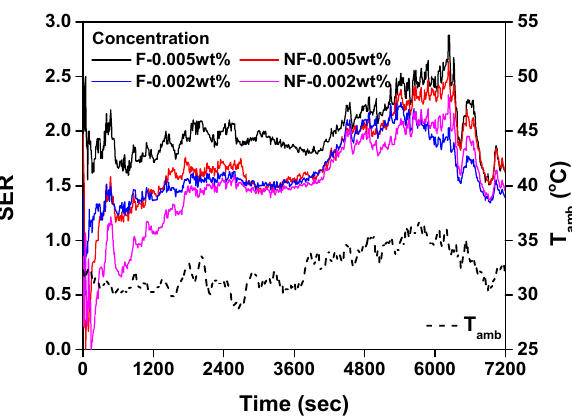
Figure 12. Stored Energy Ratio (SER) for functionalized and nonfunctionalized MWCNT nanofluid.